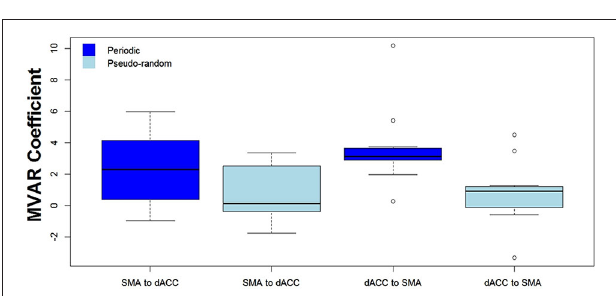
FIGURE 5 | The distribution across subjects for both directions between the 2 ROIs (SMA to dACC, dACC to SMA) and for Periodic (dark blue) and Pseudo-random (light blue) task conditions, as box plots corresponding to the bar plots in Figure 4 . Note that the distribution for the influence from dACC to SMA during the Periodic condition is both more compact than and elevated above the distribution during the Pseudo-random